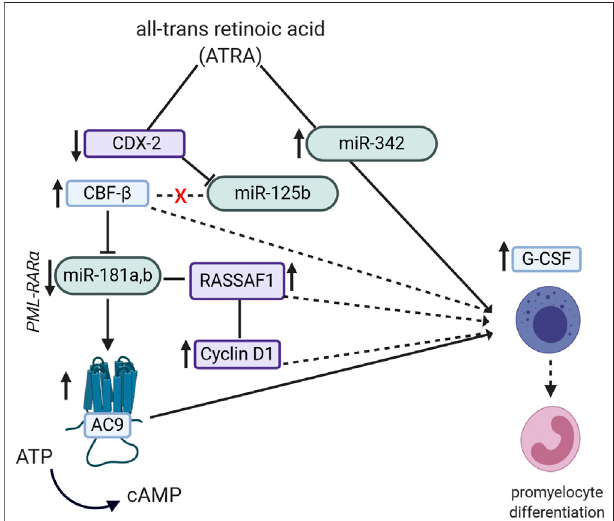
FIGURE 2 | Potential pathways by which the semi-synthetic all-trans retinoic acid (ATRA) compound can lead to promyelocyte differentiation in promyelocytic leukemia (PML). ATRA induces miR-342 up-regulation, which then leads to increased expression of G-CSF mRNA. ATRA decreases expression of homebox protein CDX2 and miR-125b as well as increases the expression of core binding factor β (CBF β ). CBF β can also modulate expression levels of miR-181a and b, which in turn modulates RASSAF1/ Cyclin D1 expression, fi nally contributing to promyelocytic